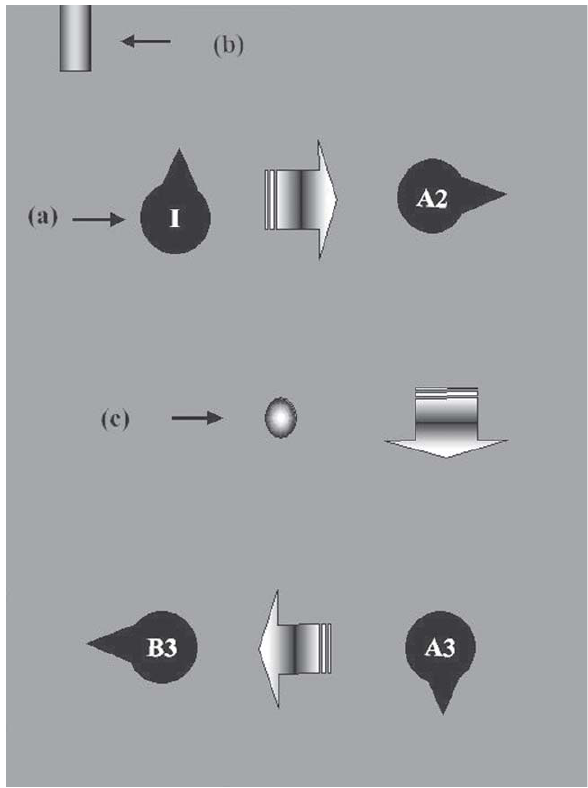
FIGURE 1- Grooves and orifices for placement, identification and escape of materials, a- outlet groove; b- identification groove of the upper left quadrant; c- central orifice for identification of PRODIGY CONDENSABLE™ resin.